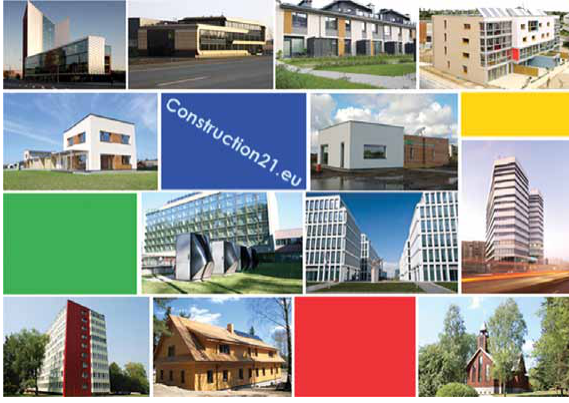
fig. 12. Construction21 case